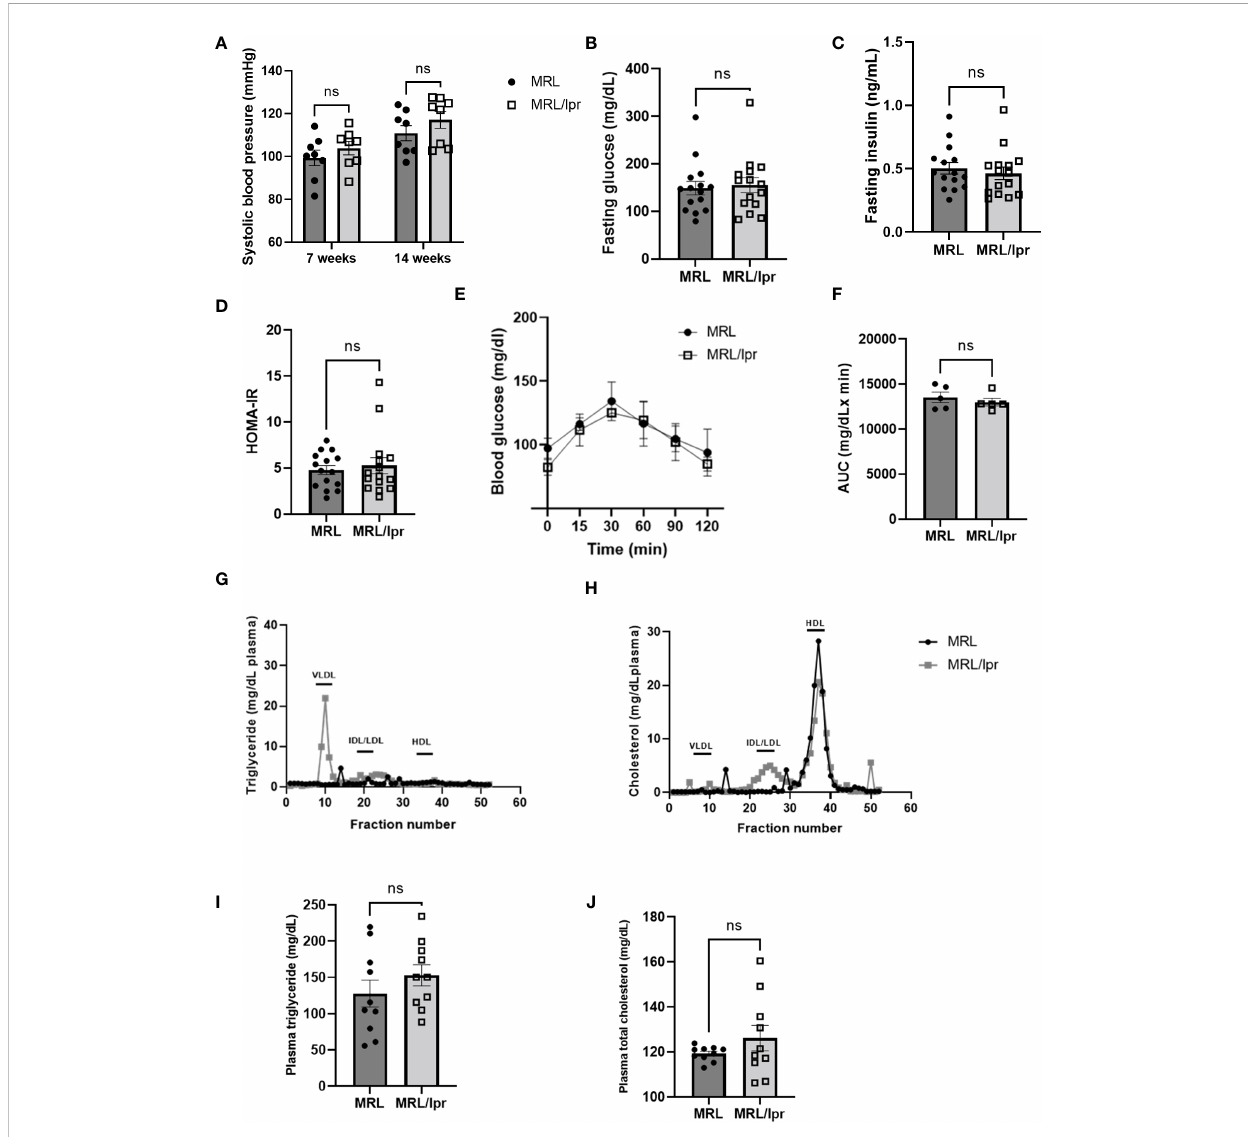
FIGURE 3 MRL/lpr mice with active disease displayed normal blood pressure and metabolic health. Systolic blood pressure (A) was measured using tail cuff (n=8). Fasting blood glucose (B) and insulin (C) levels were measured, and estimated insulin sensitivity as insulin resistance index (HOMA-IR) (D) was calculated using the University of Oxford HOMA calculator software (n=15). Glucose tolerance tests (GTT, (E) were performed and the area under the curve (AUC, (F) between MRL/lpr and MRL was compared (n=5). (G) and (H) representative plasma lipoprotein pro fi les measured via FPLC using pooled plasma (0.22 ml) from 4 MRL/lpr mice and 5 MRL mice. Plasma levels of triglyceride (I) and cholesterol (J) were also measured using biochemical assays (n=10). VLDL, very low-density lipoprotein; IDL, intermediate-density lipoprotein; LDL, low-density lipoprotein; HDL, high-density lipoprotein. ns, not signi fi